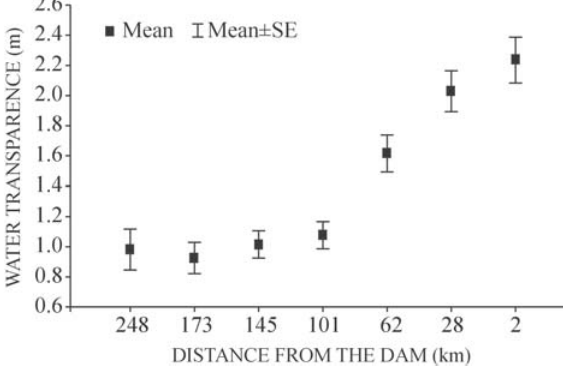
Fig. 3. Mean values of water transparency (Secchi disc, m) upstream from (248 and 173 km) and within Lajeado Reser- voir, from October, 2003 through September, 2004.